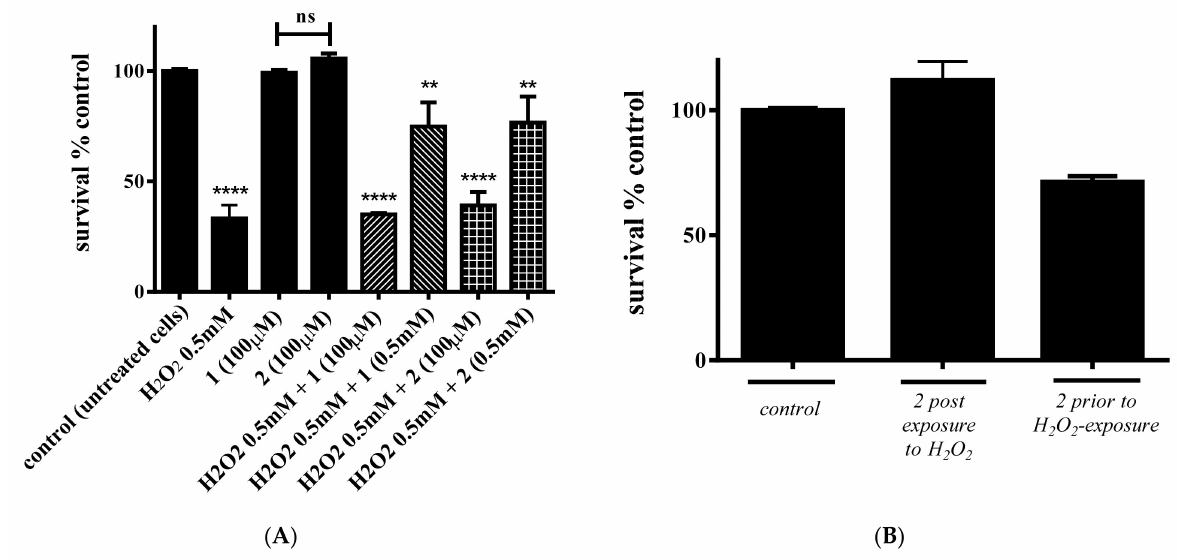
Figure 9. Percent change of cell survival in C2C12 myoblasts, following ( A ) concurrent treatment of cells with either 1 or 2 and H 2 O 2 , and ( B ) treatment with 2 either prior to or following exposure to H 2 O 2 . Values represent the mean value of several (n = 3) independent experiments. Vertical bars represent SEMs. **: p < 0.01; **** p ≤ 0.0001 vs. control. ns: not statistically significant ( p >